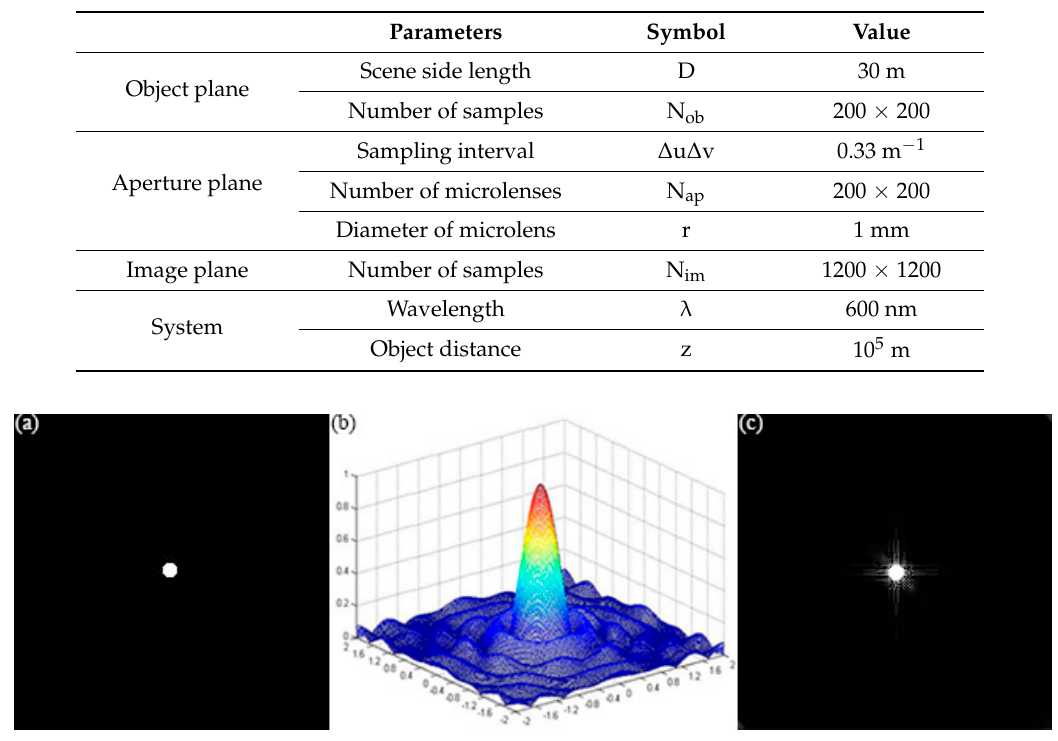
Figure 3. ( a ) Light intensity distribution of target source; ( b ) detected spatial frequency distribution; ( c ) image obtained by inverse Fourier